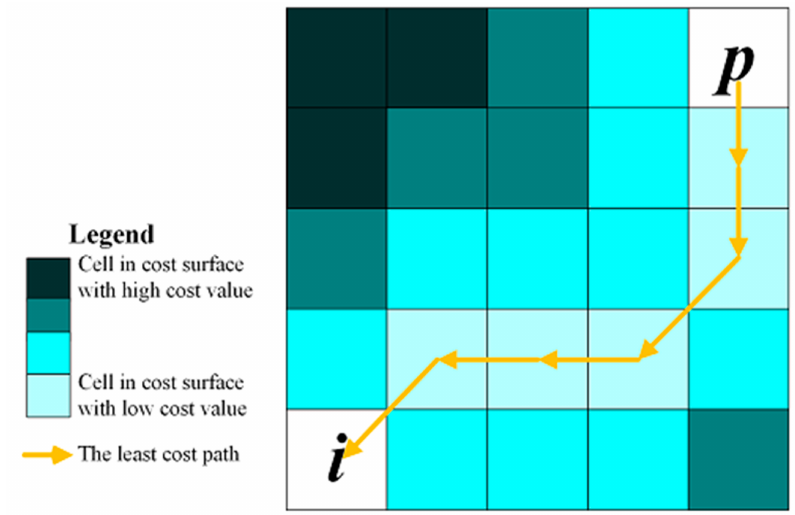
Figure 1. A cost